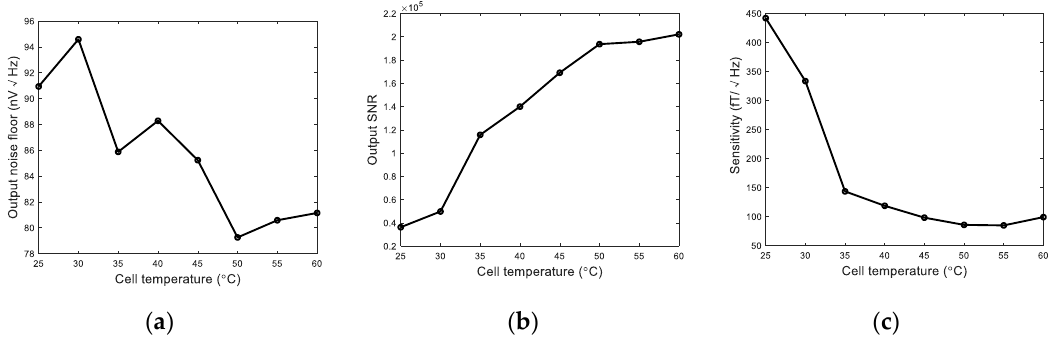
Figure 13. ( a ) Result of the output noise floor changing with the cell temperature. ( b ) Result of the output SNR changing with the cell temperature. ( c ) Result of the sensitivity changing with the cell temperature.